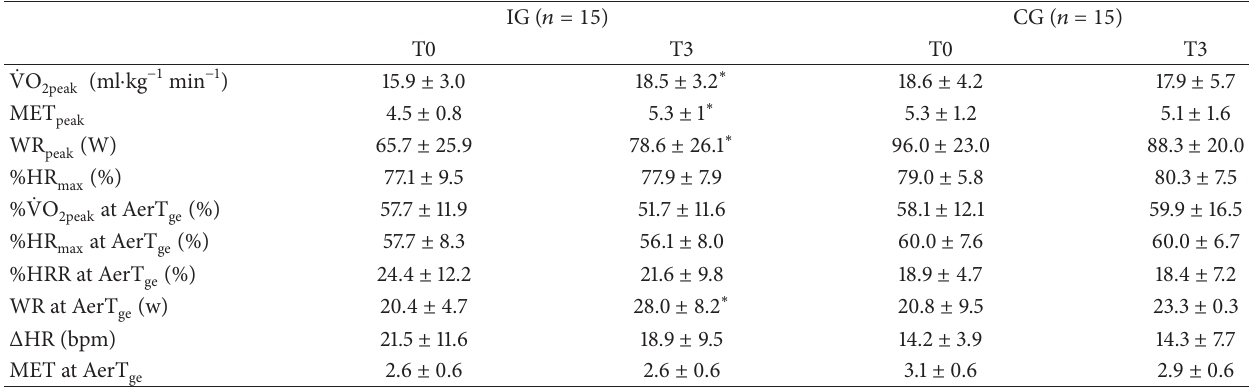
Table 2: Physiological parameters for the intervention group (IG) and the control group (CG) at baseline and after 3-month period. IG ( 𝑛 = 15 ) CG ( 𝑛 = 15